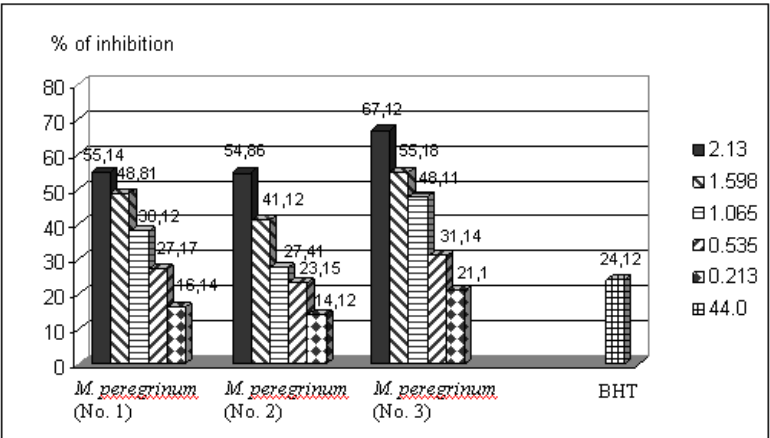
Figure 1. Inhibition of degradation of 2-deoxyribose by essential oils of M. peregrinum from three different locations, and BHT (as a positive control). The essential oils and BHT were diluted in n -hexane (the solvent expressed no antioxidant activity) in the deoxyribose